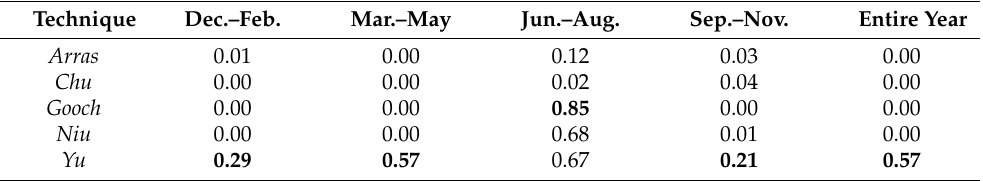
Table 3. Digisonde and GPS-RO mean statistical similarity for no lower limit on E s intensity. Bold values highlight the largest statistical similarity for each